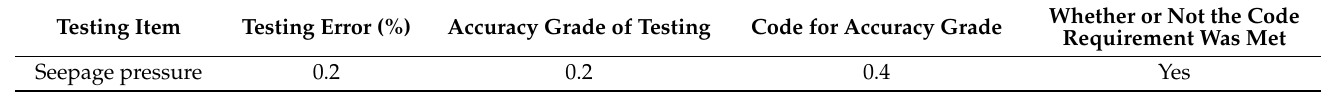
Table 3. Results of the metrological verification of seepage pressure.